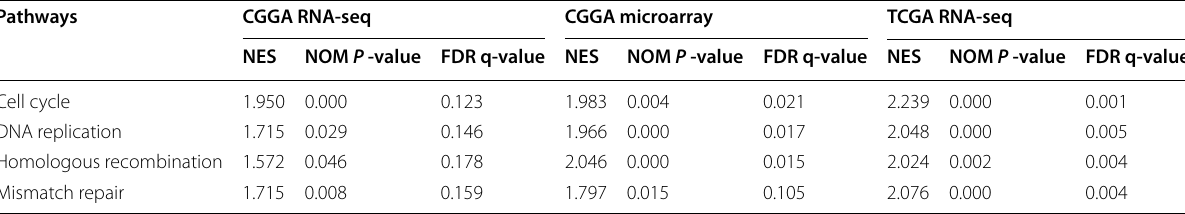
Table 2 Signal pathways involved in XRCC2 in glioma based on three datasets Pathways